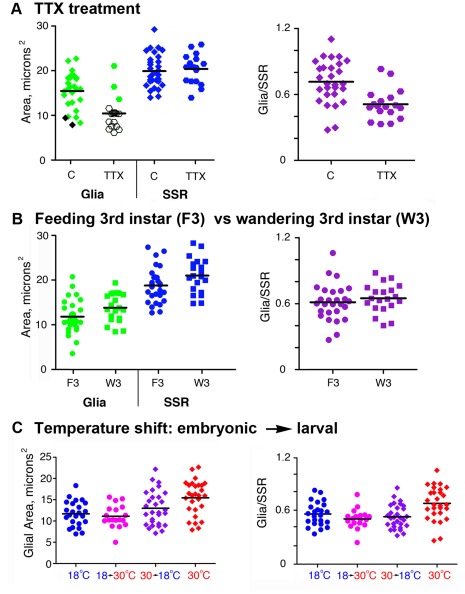
Changes in motor activity and synaptic growth affect the presence of glial processes at the larval NMJ.Live NMJs from F3 larvae with glial processes labeled using repo>CD8GFP, neurons immunolabeled with anti-HRP and the SSR labeled with ShCter-DsRed. A) TTX treatment: comparison of glial process areas (green) and SSR areas (blue) from control (C, diamonds) or TTX treated (TTX, hexagons) larvae raised at 30°C. TTX significantly reduced the mean area of glial processes relative to control animals (P<0.0001) but had no effect on the mean SSR area. Black symbols represent NMJs with glial processes that stopped at the motor axon end just prior to the first bouton. The mean ratio of glial process to SSR area (magenta) was significantly reduced in TTX treated larvae (hexagons) compared to control larvae (diamonds) (P<0.0004). B) F3 compared to W3: comparison of glial (green) and SSR areas (blue) from feeding third instar (F3, circles) or wandering third instar (W3, squares) larvae raised at 25°C. Mean glial areas and mean SSR areas were not significantly different between F3 and W3. The mean ratio of glial to SSR area (magenta) in F3 larvae (circles) was comparable to the ratio in W3 larvae (squares). C) Temperature shift treatment: comparison of glial areas from larvae reared continuously at 18°C (blue circles), shifted from 18°C to 30°C (pink circles), shifted from 30°C to 18°C (purple diamonds) and raised continuously at 30°C (red diamonds). The mean glial area from larvae transferred from 18°C to 30°C was significantly smaller than in larvae grown continuously at 30°C (P<0.0002), but the same size as larvae grown at 18°C. The mean ratio of glia to SSR area at 30°C constant rearing temperature was significantly different from all other protocols (P<0.002).